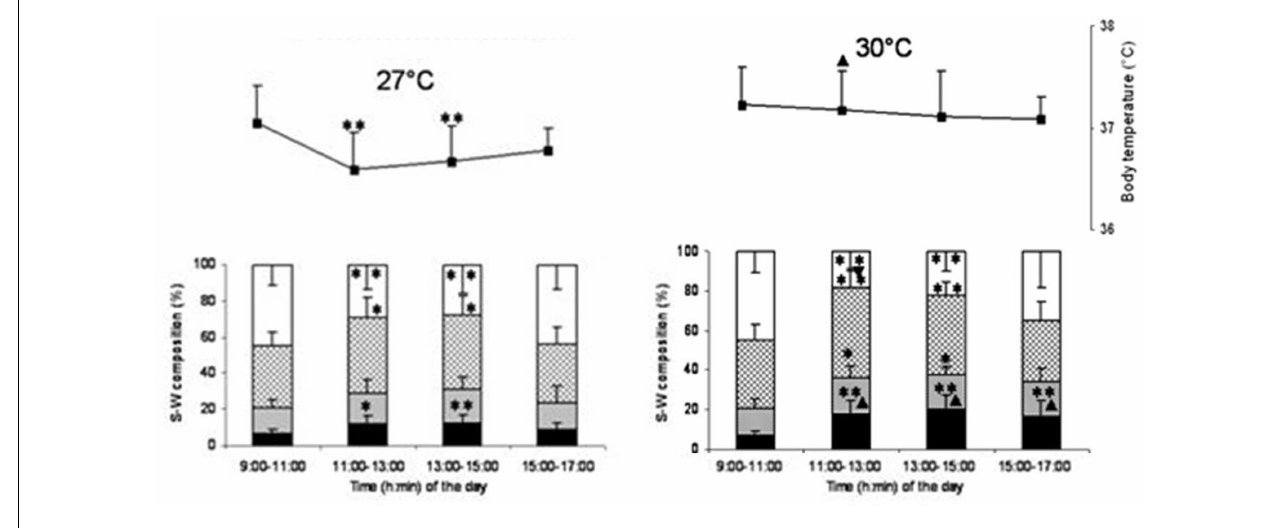
FIGURE 2 | Sleep-wake stages (bar diagram) and body temperature (line diagram) in 2h bin at 27 and 30˚C ambient temperature. Sleep parameters and body temperature recording for 6h (11:00–17:00hours) at 27 and 30˚C was preceded by 2h baseline recording (9:00–11:00hours) at 27˚C. X -axis shows the time of the day. Y -axis shows percentage time (mean ± SD) of recordings (bar